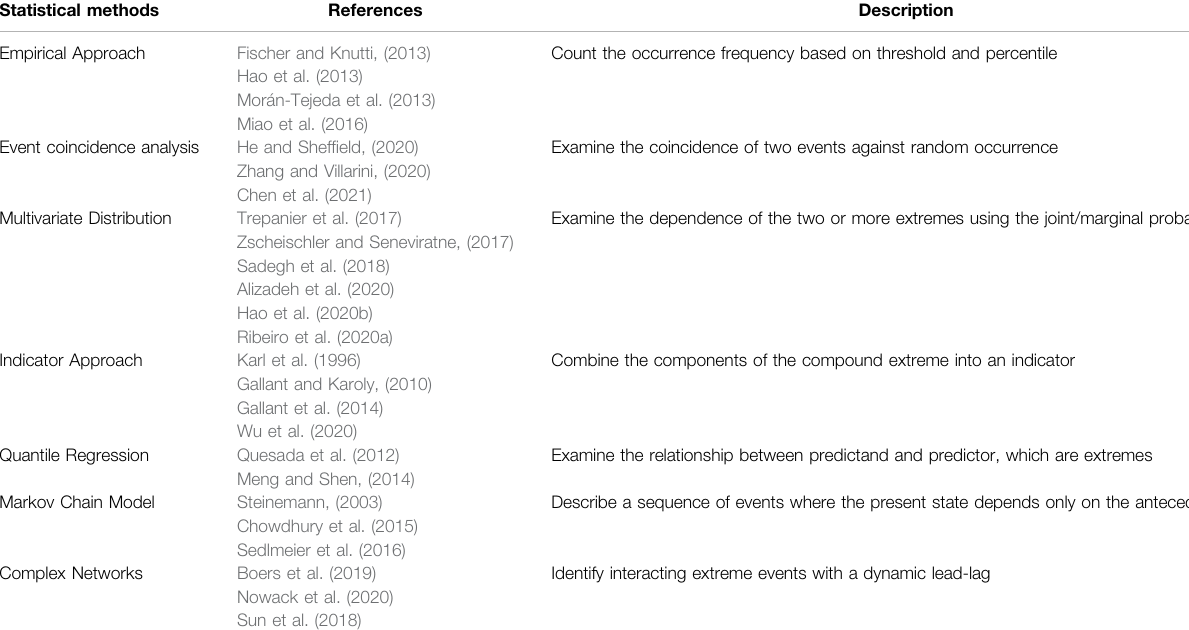
TABLE 4 | Statistical methods for studying compound